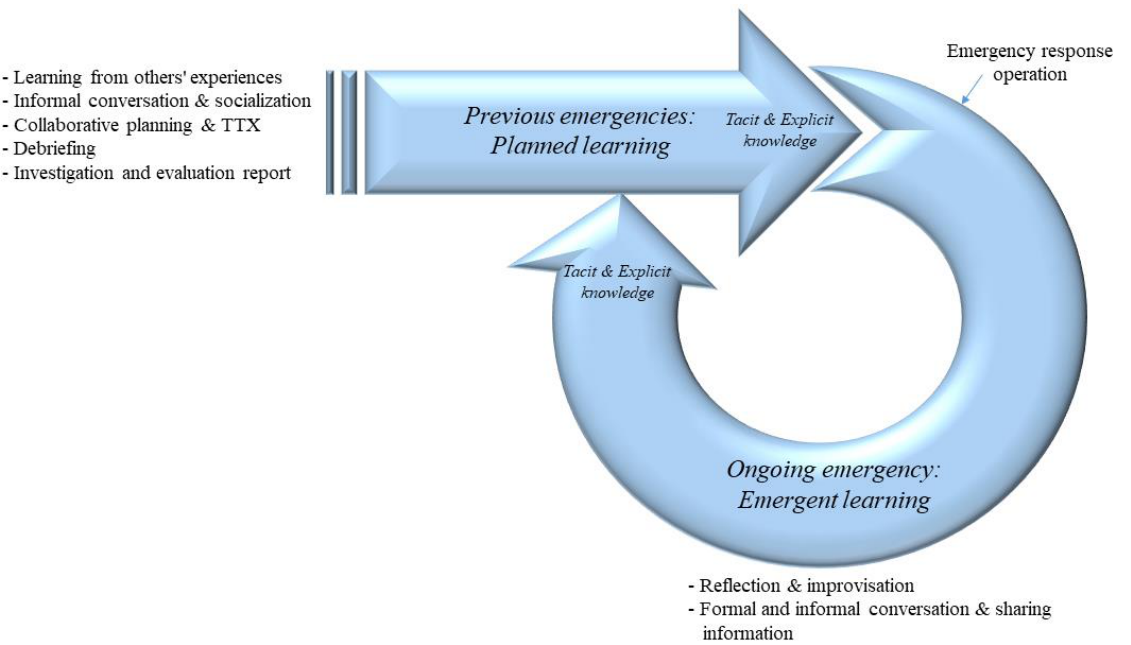
Figure 1. Pattern of learning, sources, and stances.